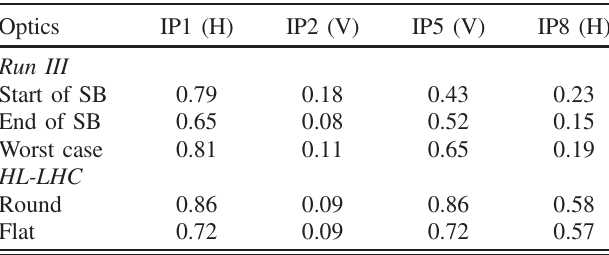
TABLE V. Results of the BBK simulations per IP for Run